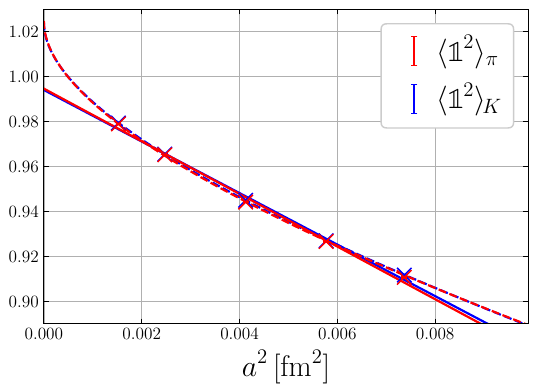
Figure 5 . The quantity 1 2 as a function of the squared lattice spacing a 2 , plotted at the physical (cid:31) (cid:30) M mass point. The solid lines represent the result of a global fit using eq. (4.1). The points shown have been obtained by translating all data points to the physical masses along the fitted function and then averaging measurements from the same lattice spacing. The dashed curves correspond to the alternative fit carried out to investigate linear terms as described in the main